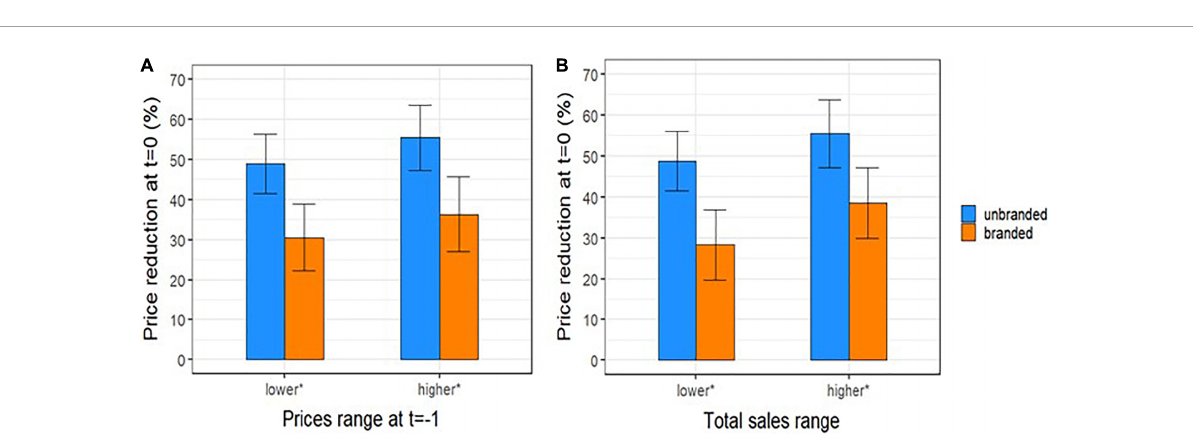
FIGURE5 Percentage reduction (mean and 95 % CI) between price per dose of unbranded and branded off-patent drugs at lag time t ( t = 0) and branded price a year before the patent expiration, t = –1 (i.e., 12 months before the index date) by (A) category of price at time t = –1 and (B) by total sales range at t = 0. *Median values (1,02 € and 19,6 million of €) were considered as cut-off to categorize prices per dose at t = –1 and total sales at t = 0,